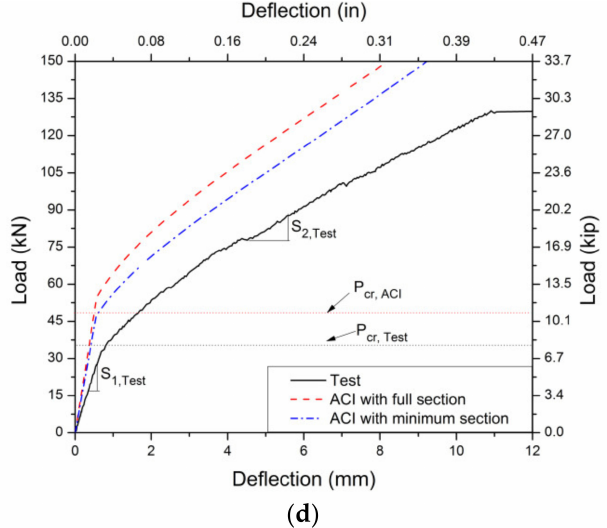
Figure 15. Comparing between theoretical and experimental stiffness based on section properties: ( a ) Solid; ( b ) OF-V-S-D; ( c ) OF-V-M-D; ( d )